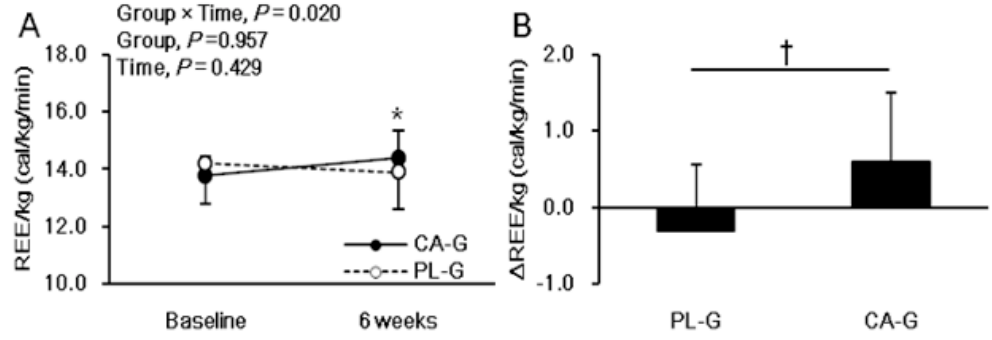
Figure 5. Mean (± SD) REE/kg at baseline and after 6-week ingestion of capsinoid ( ● ) and placebo ( ○ ) in the overweight (BMI ≥ 25 kg/m 2 ) subgroup ( n = 24) ( A ). Mean (± SD) changes in REE/kg after the 6-week intervention in the overweight subgroup ( n = 24) ( B ). There was a significant intervention interaction (group × time, P = 0.020); however, no main effects on the group ( P = 0.957) or the time ( P = 0.429) were observed by ANOVA. The post hoc comparison between baseline and 6 weeks showed a significant increase in REE/kg ( P = 0.041) only in the CA-G (A; * P < 0.05). A Welch test was conducted which indicated that there was significant difference between the CA-G and PL-G (B; † P < 0.05). CA-G, capsinoid group; PL-G, placebo group; REE/kg, resting energy expenditure per kg.